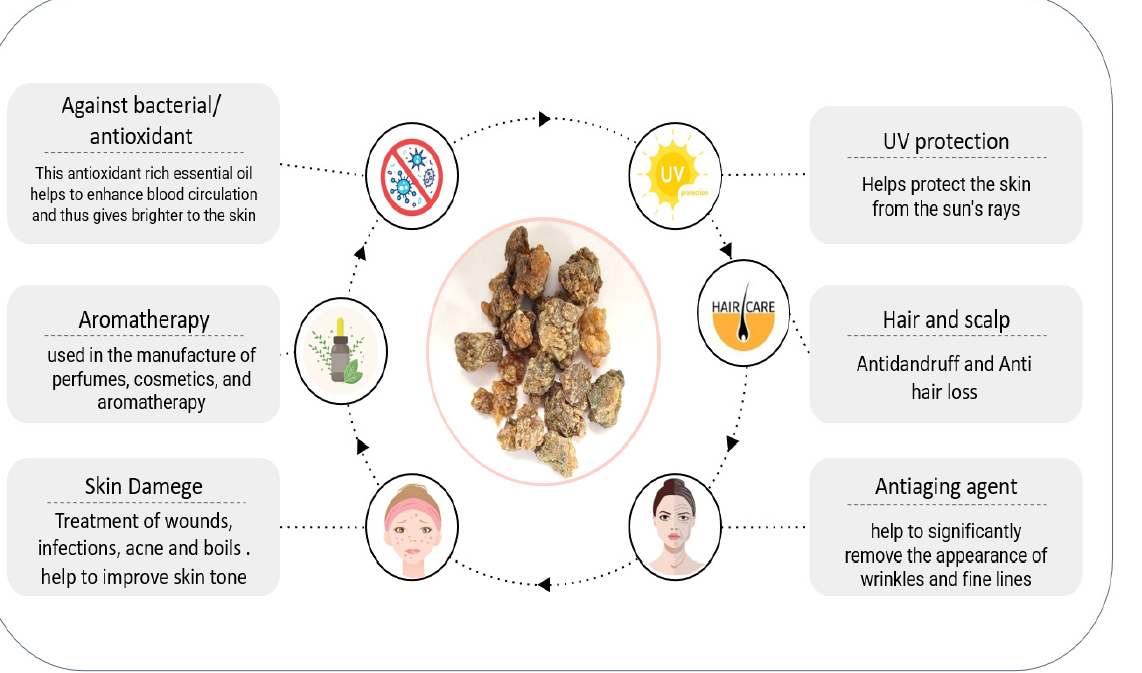
Figure 3. The illustrated summary of the cosmetic uses of C. myrrha .